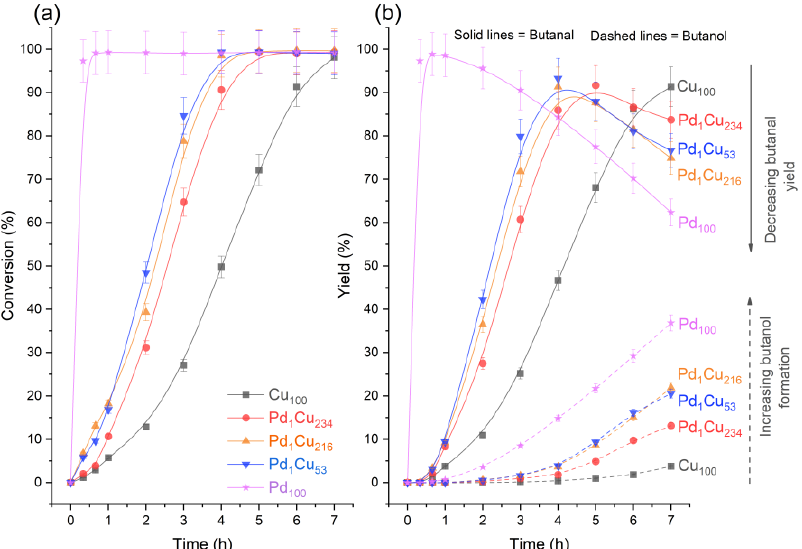
Figure 2. Reaction profiles for the hydrogenation of crotonaldehyde. ( a ) crotonaldehyde conversion and ( b ) yield of major products across monometallic and bimetallic catalysts. Reaction conditions: 7 h, 50 °C, 1.5 bar, 600 RPM, and 10 mg of catalyst.